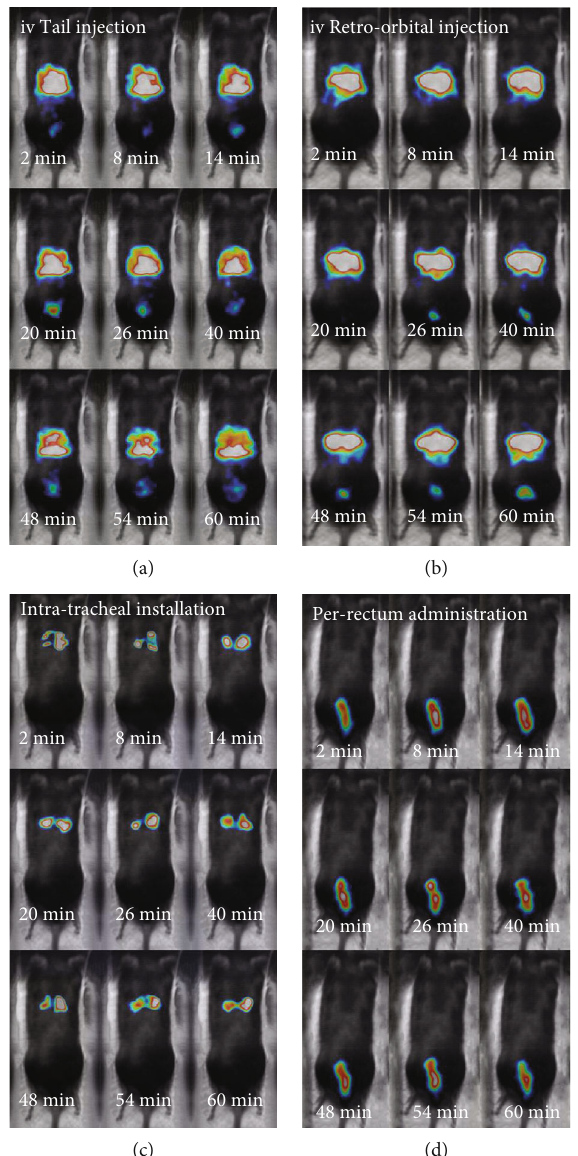
Figure 7: In vivo molecular screening for all tested routes with γ -eye ™ , over the fi rst hour p.i.: (a) standard IV tail vein injection, (b) retro- orbital IV injection, (c) intratracheal installation, and (d) per rectum administration. Time point postinjection is shown on each image. All images are decay-corrected. Indicative images are shown ( n = 5 for each administration